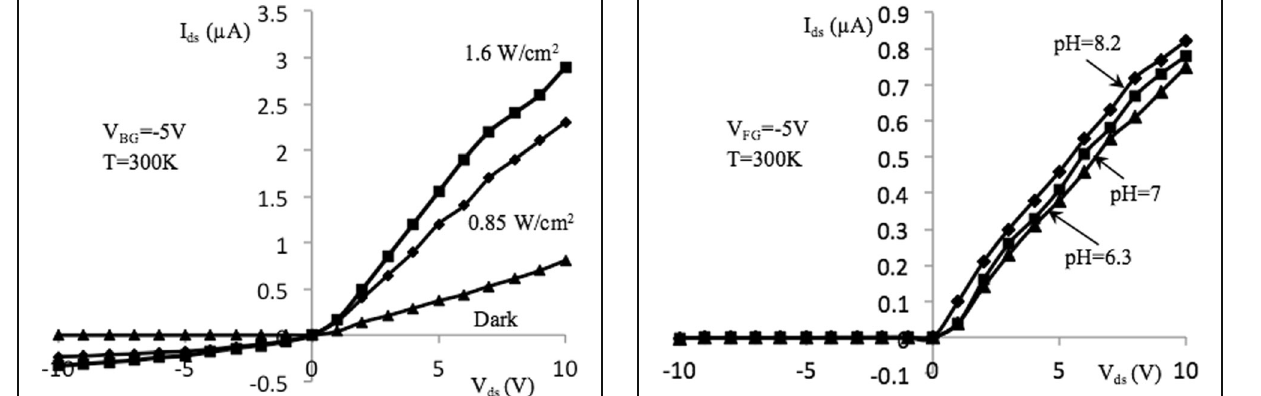
Fig. 4 I – V characteristics of NW FET, measured at optical excitation ( V BG = − 5 V). Output current – voltage characteristics of NW FET sample with length l = 10 μ m, measured in the dark and with excitation by the light specific power 0.85 and 1.6 W/cm 2 at T = 300 K and V BG = − 5 V